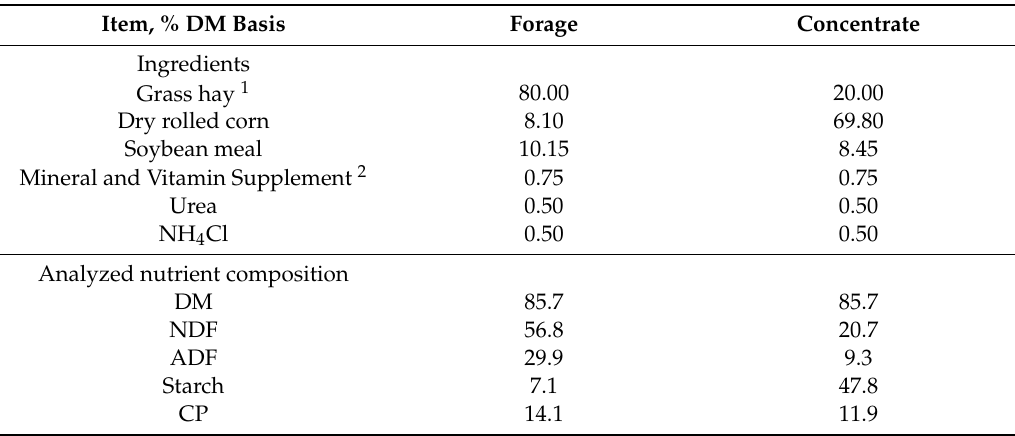
Table 1. Composition of diets fed to